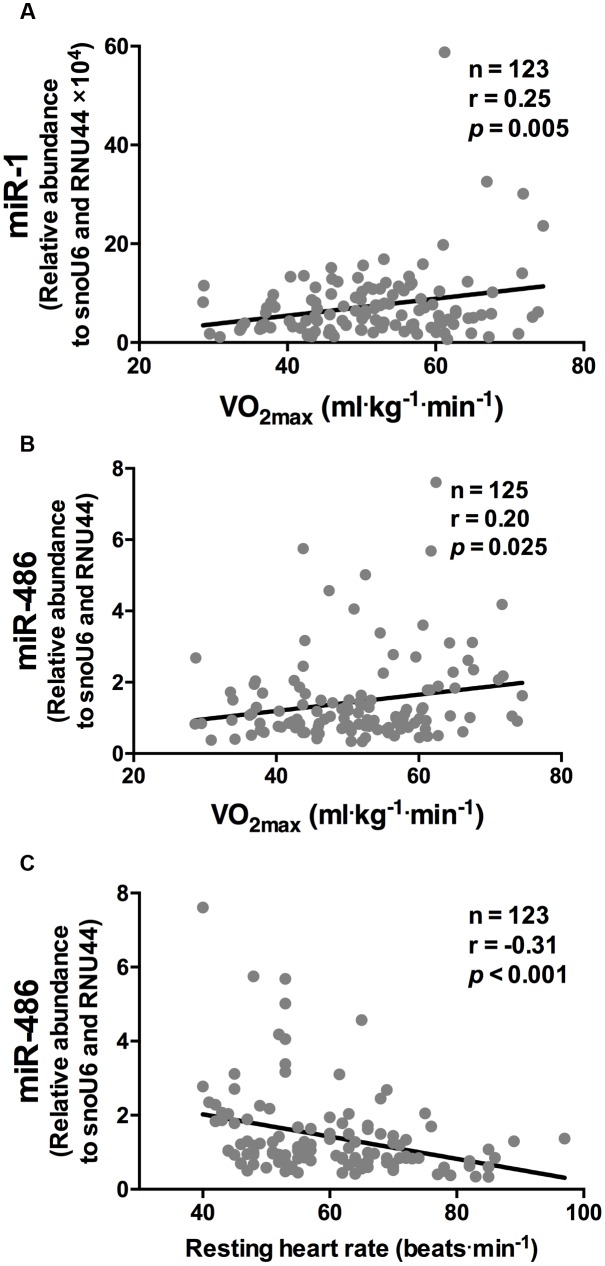
miR-1 and miR-486 are associated with cardiorespiratory fitness parameters. While miR-1 (A) and miR-486 (B) were positively correlated to O2 max, miR-486 (C) was inversely related to resting heart rate (n = 123–125). Data are from two-tailed Pearson correlation and expressed as relative abundance normalized to RNU44 and snoU6.